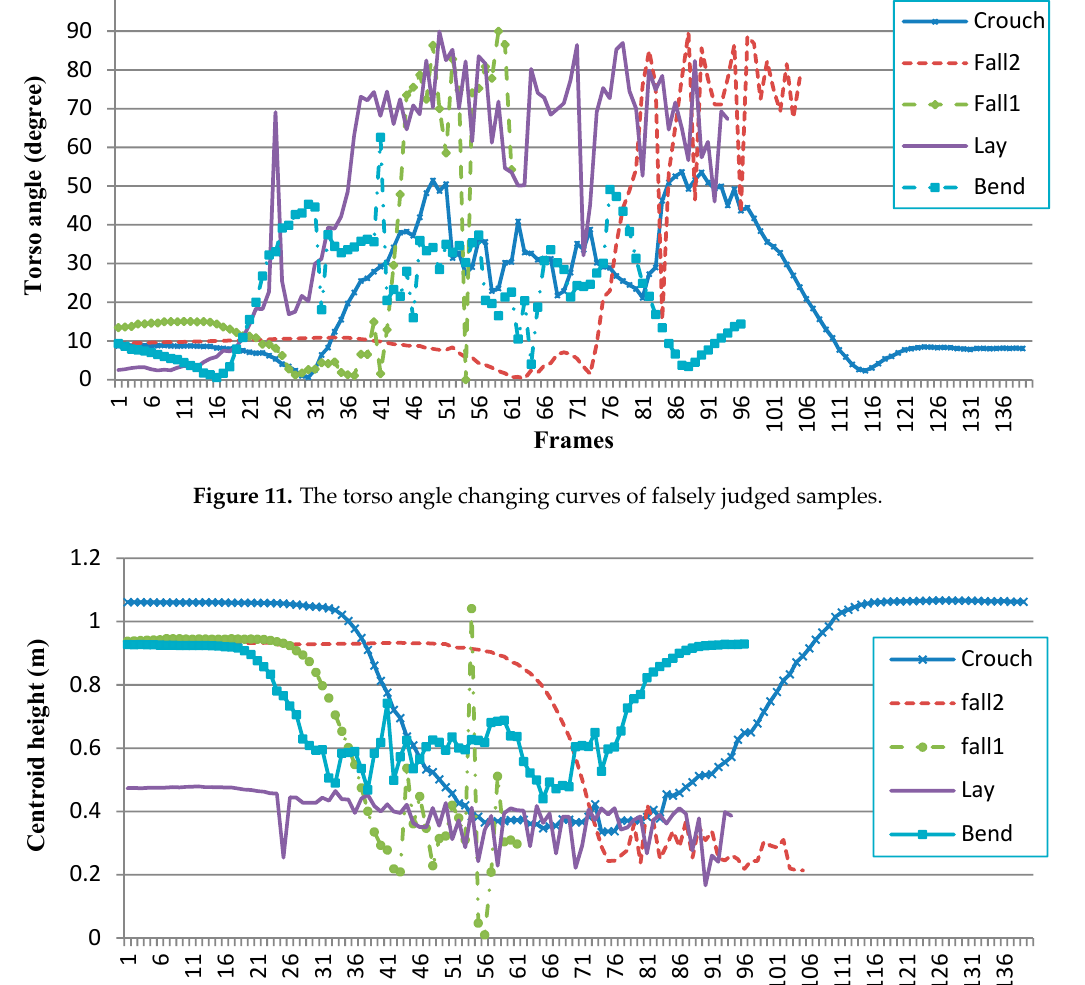
Figure 13. The time consumptions of each frame in walk and fall. The two test videos of this graph were selected randomly from the self-collected dataset.